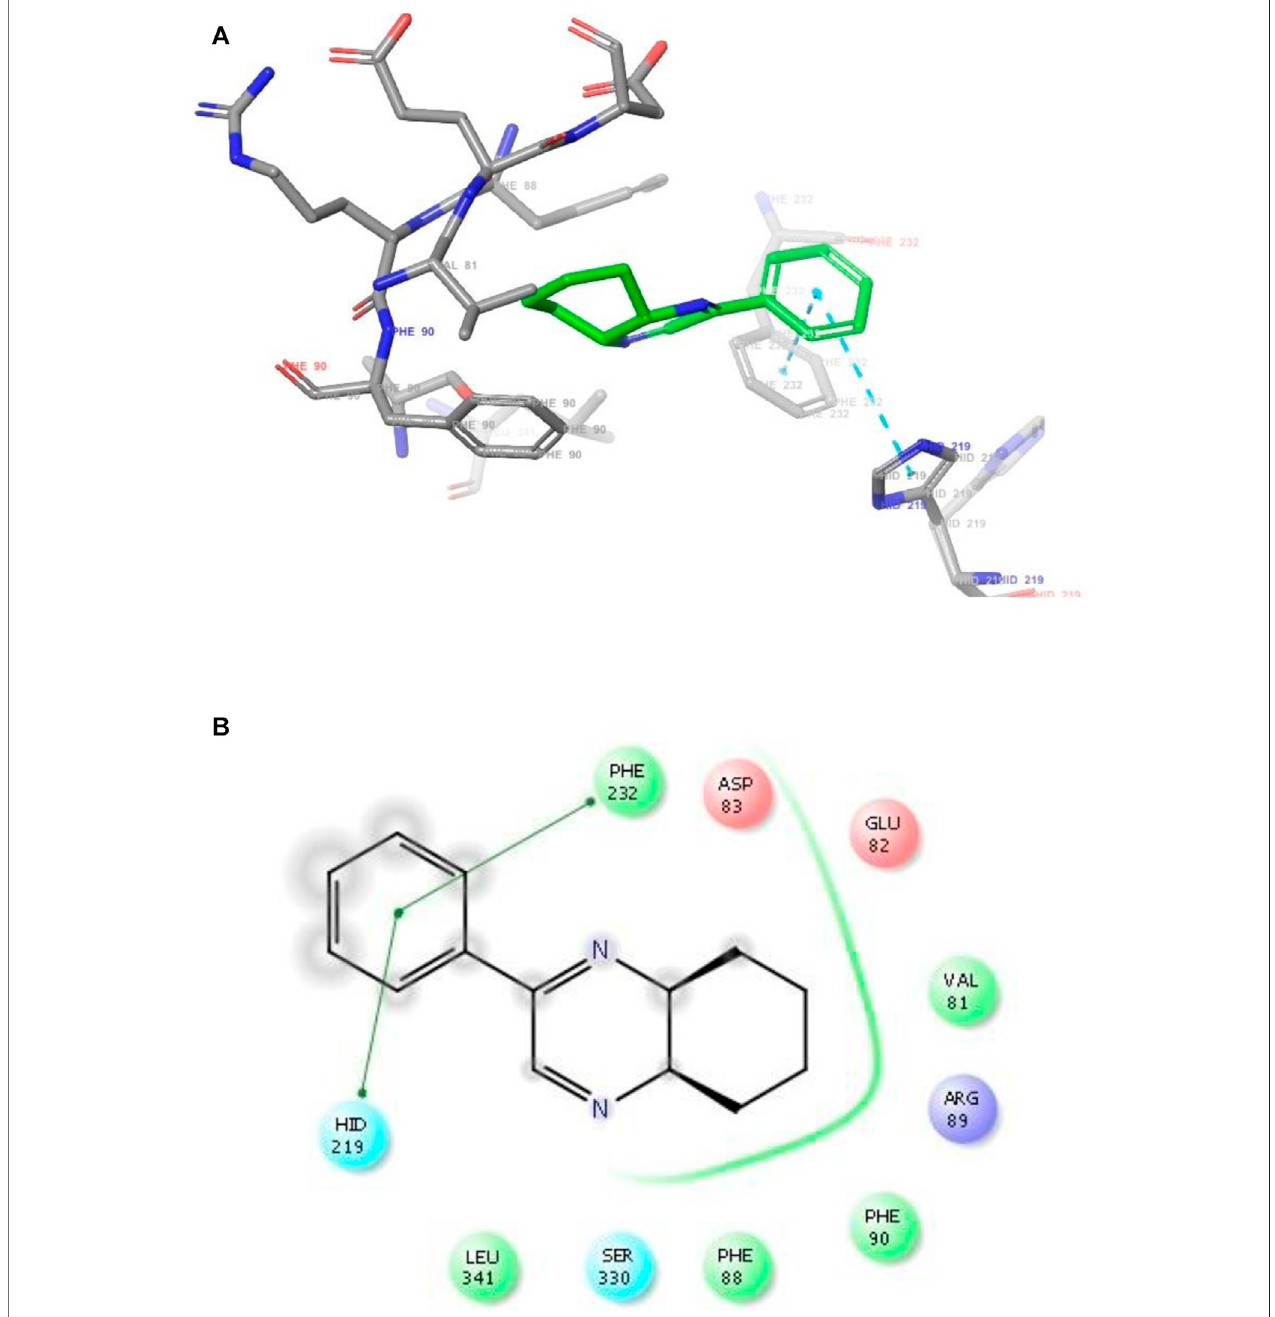
FIGURE 5 | (A) The binding mode of the interactions between 1 with Leishmania major N -myristoyltransferase (PDB ID: 6QDA). (B) Results of the validation of 1 inside the Leishmania major N -myristoyltransferase active sites.